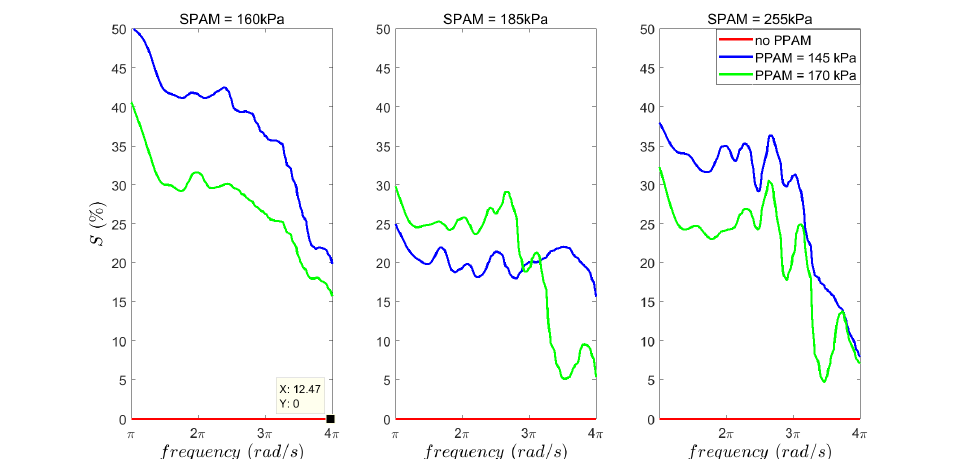
Figure 9. Integration of PAM in BioBiped3. Implementation of EPA in BioBiped3 representing the Vastus muscle, including one electric motor (EM), one serial (SPAM) and one parallel PAM (PPAM). The knee joint angle is PID controlled. The desired joint position is a sinusoidal wave with frequency linearly increasing from π rad/s to 4 π rad/s (0.5 Hz to 2 Hz), over a period of 5 min. The approximation of saved energy (S) compared to no PPAM case is shown for different PAM pressures and oscillations frequencies. The atmosphere pressure is about 100